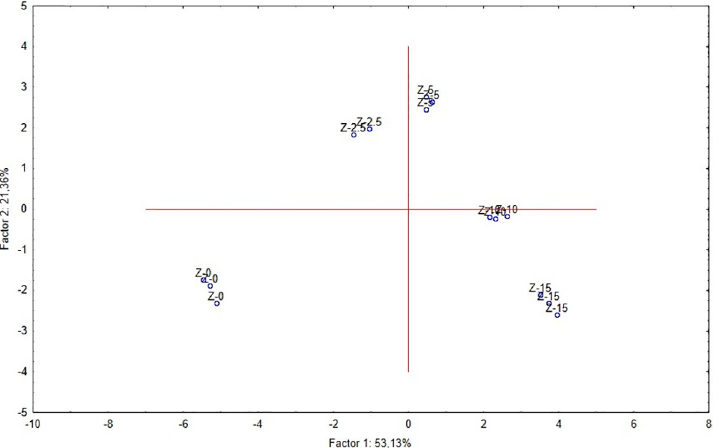
Fig 2. Projection of the variables of the factor plane. The correlation matrix is singular, so the generalized reciprocal method is used.